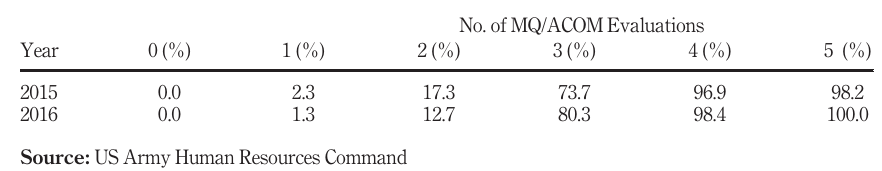
Table I. Promotion rates for majors based on the number of MQ or ACOM